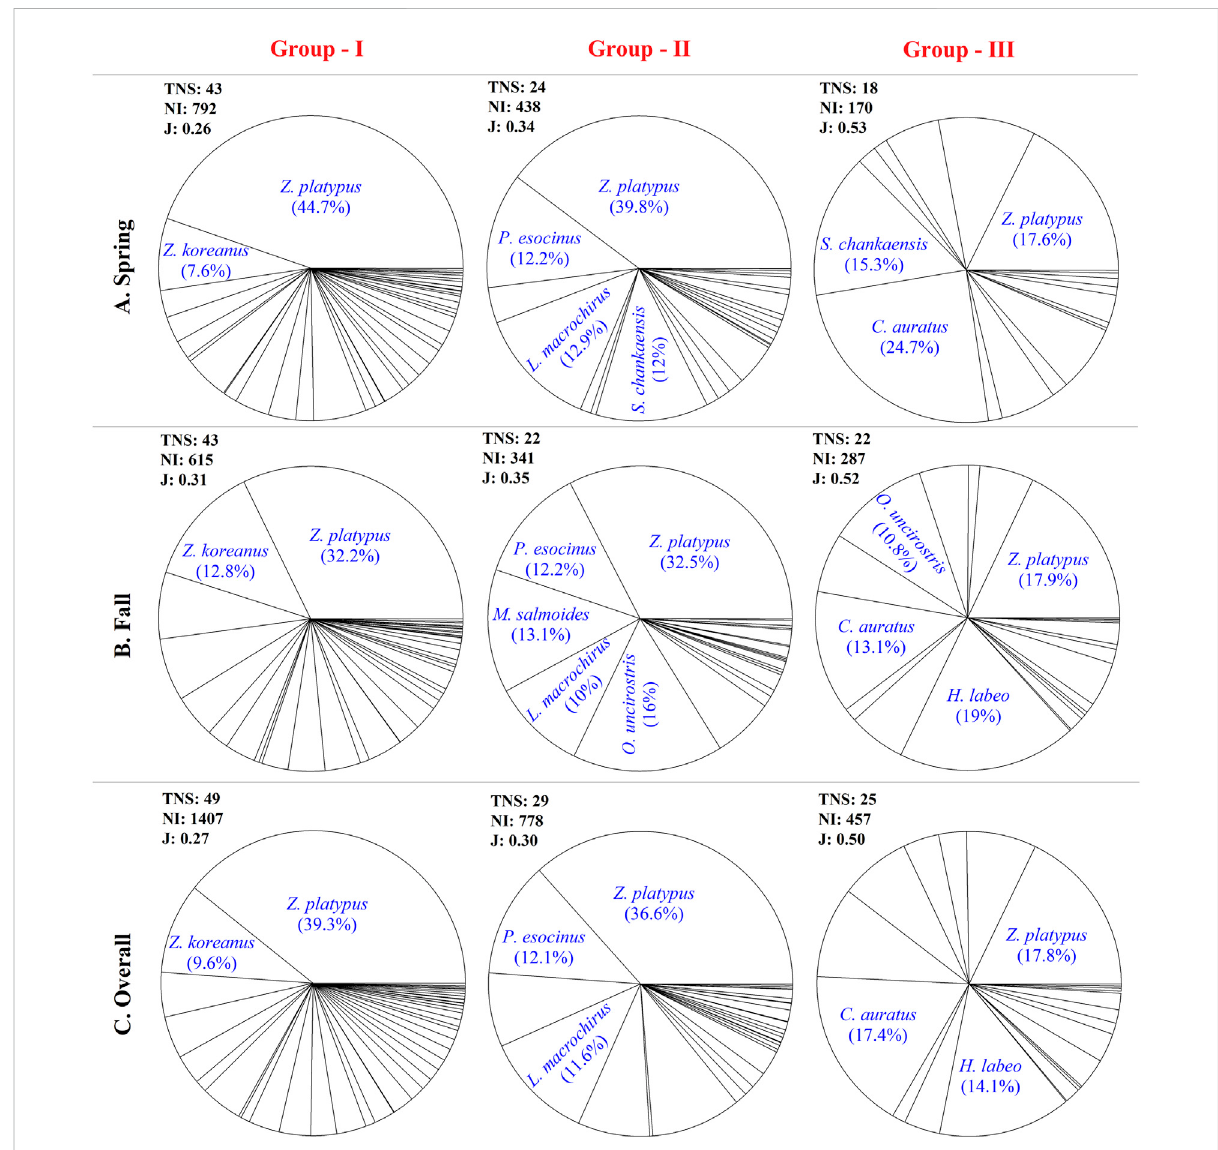
FIGURE 5 Seasonal and overall differences of fi sh communities among the spatial water quality groups that determined by